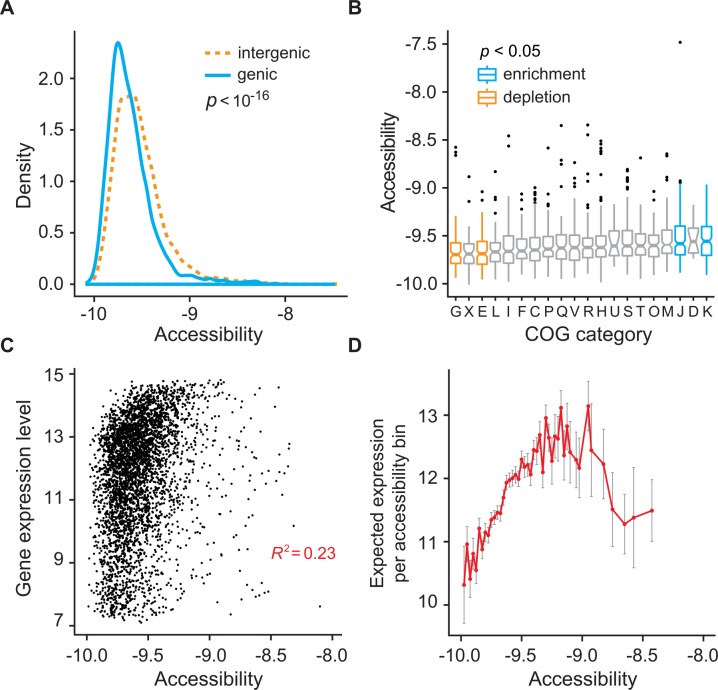
Genome accessibility correlates with genomic features.(A) Intergenic regions are more accessible than protein coding genic regions (p<10−16). (B) Regions associated with amino acid and carbohydrate metabolism and transport (COGs E and G) show statistically reduced accessibility. Genes associated with transcription and translation (COGs K and J) show statistically higher accessibility (p<0.05, Bonferroni correction). (C) Gene expression is positively correlated with accessibility. The correlation of DNA accessibility with gene expression after controlling for values of motif affinity is 0.278 (p<3.98 10−56-; function pcor and pcor.test, R package ggm). (D) Expected gene expression is highest at an intermediate level of accessibility. Accessibility bins with less than 10 data points are clustered with the neighboring bin with fewer data points. Error bars represent one standard error from the mean.